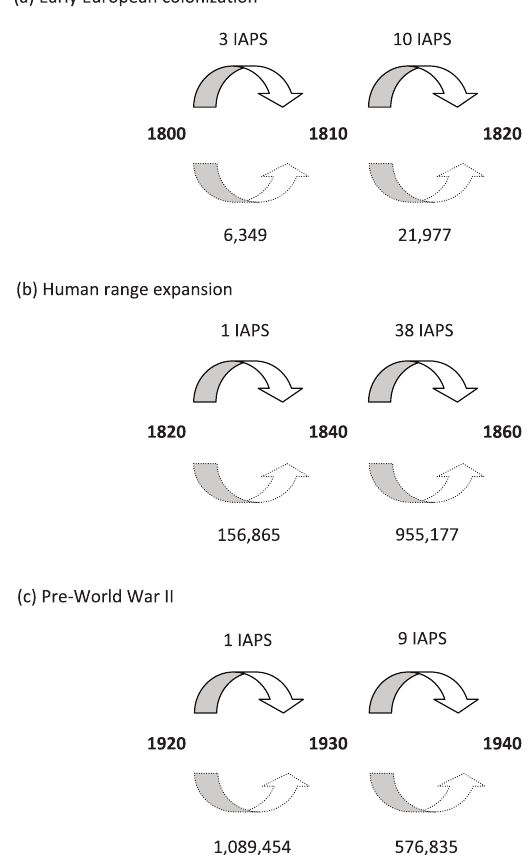
Figure 4. Increases in IAPS (numbers of species above arrows) and Australia’s human population (number of people below arrows) in relation to time (years shown between arrows) during a early European colonization b human range expansion and c pre-World War